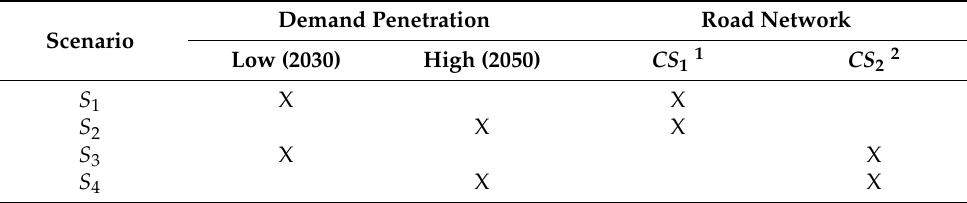
Table 4. Base case scenarios for hydrogen transport and storage in France and Germany.